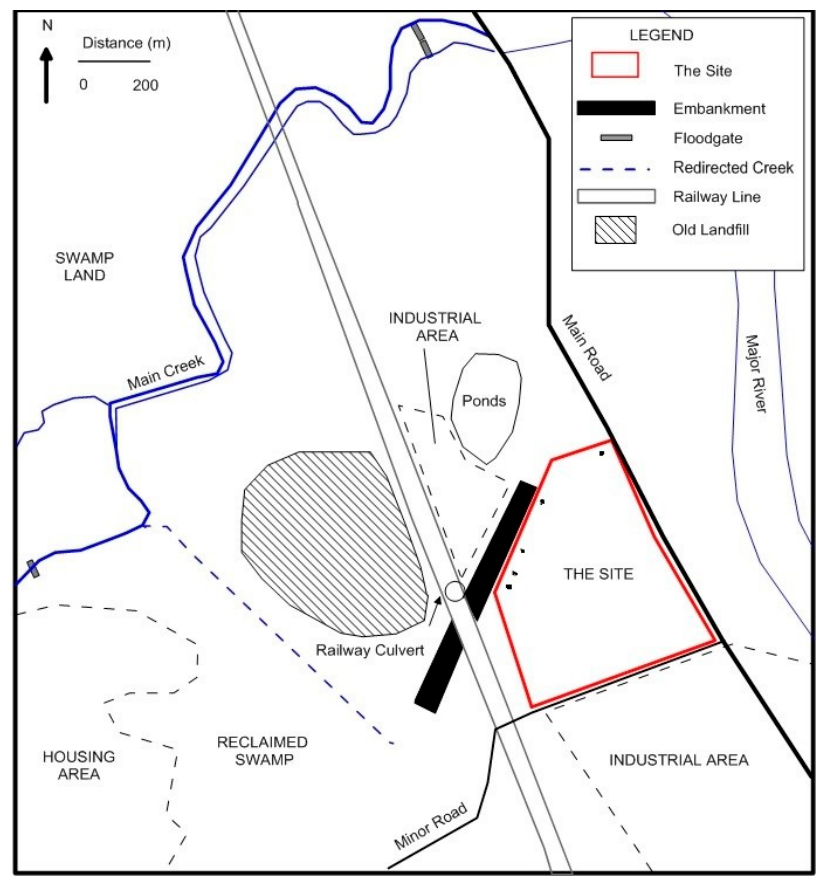
Figure 1. Study area and site showing the land use. Observation wells shown as black dot points inside the study area.